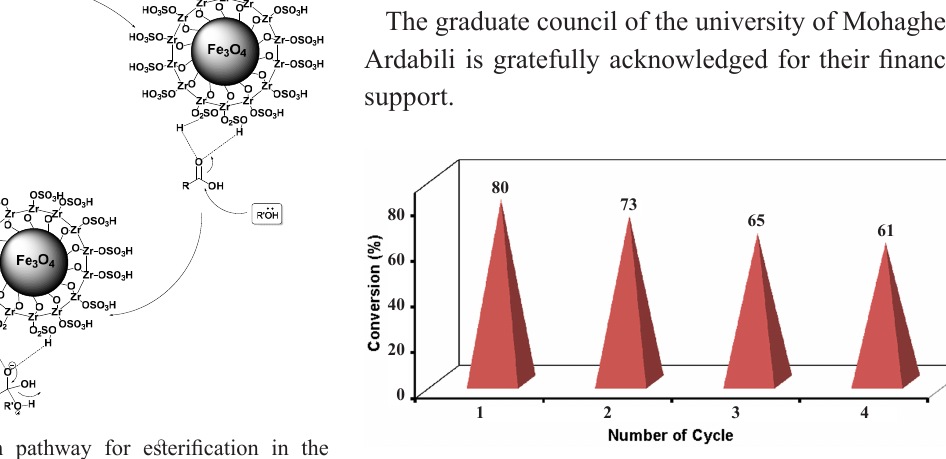
Fig 8. Recyclability of Fe 3 O 4 @ZrO 2 -SO 3